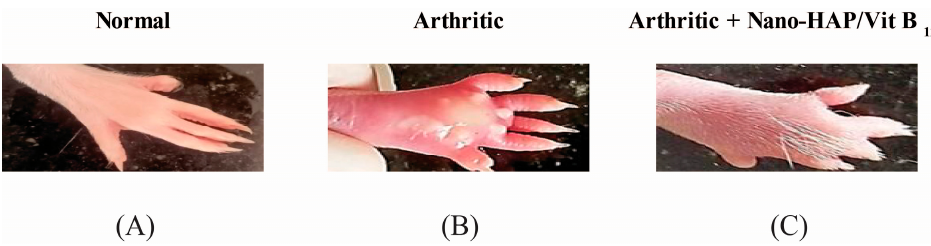
Figure 4. Gross morphology of rats in various groups: ( A ) normal rats; ( B ) arthritic rats; ( C ) arthritic rats receiving nano-HAP/Vit B 12 .